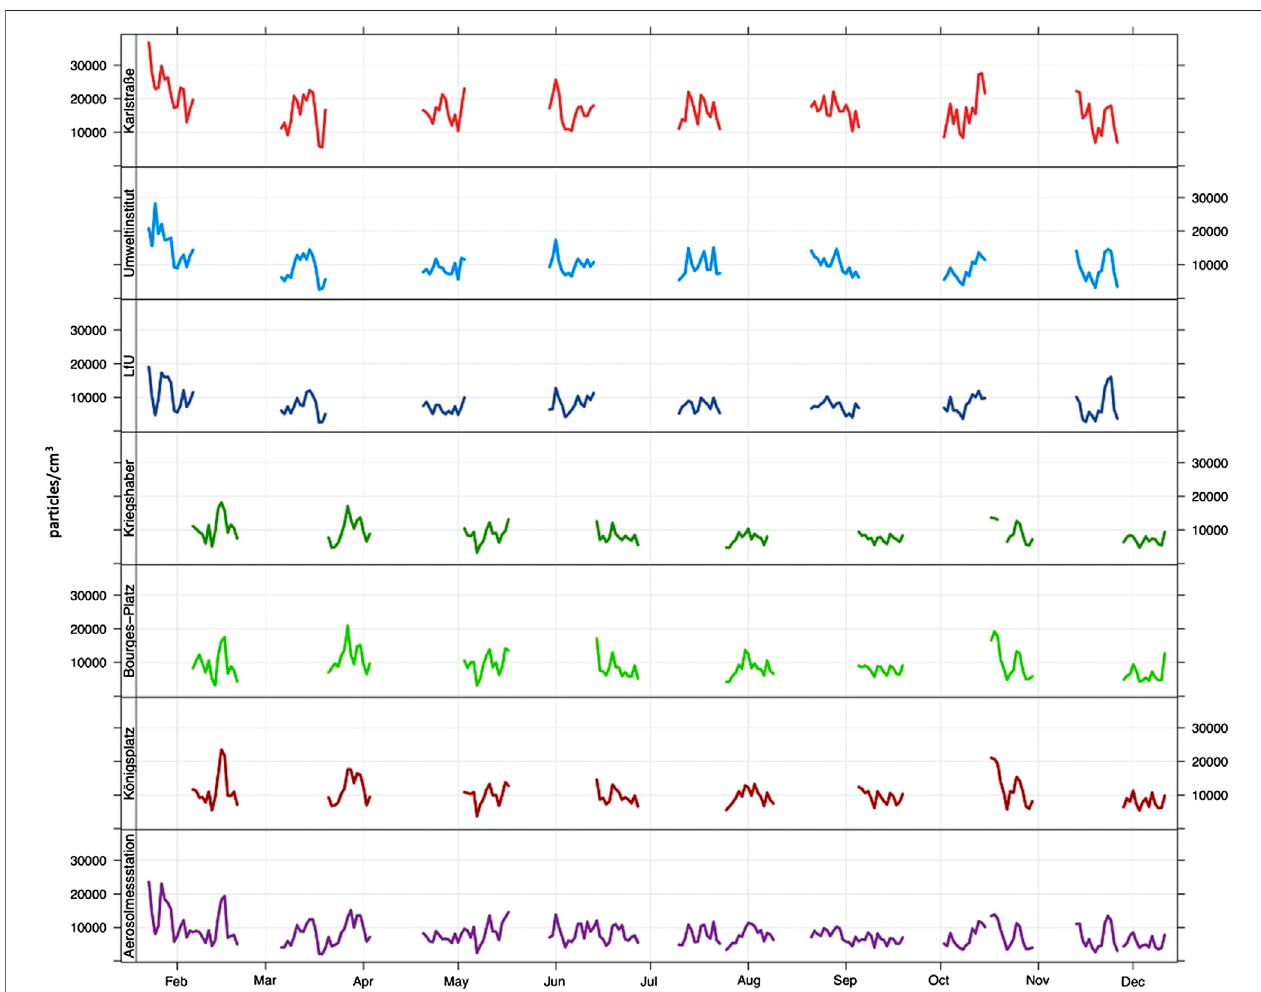
FIGURE 3 | Time series of the daily UFP number concentrations in particles/cm 3 from the eight fi eld measurement phases of the measurement campaign 2017.